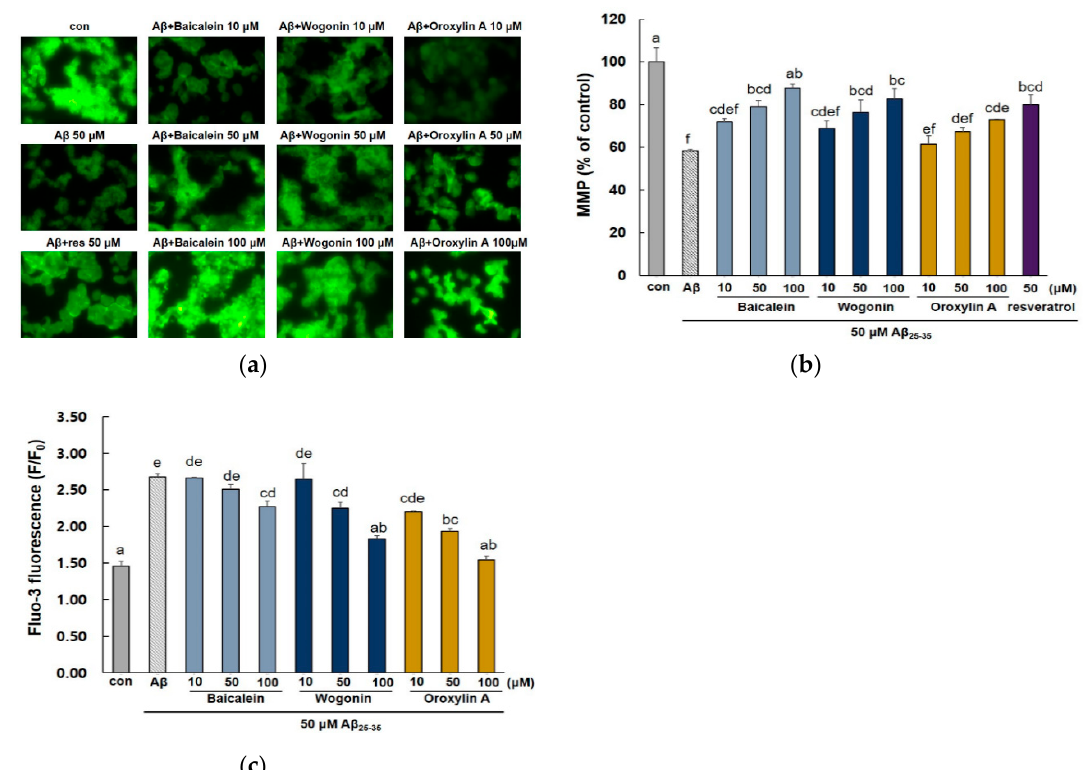
Figure 5. Effects of baicalein, wogonin, and oroxylin A on A β 25–35 induced mitochondrial dysfunction. The cells were pretreated with samples for 1 h and stimulated with A β 25–35 for 24 h. Mitochondrial membrane potential (MMP) was determined by Rhodamine 123 staining ( a ). Statistical analysis results of the percentage MMP through Rhodamine 123 intensity ( b ). Intracellular Ca 2+ levels were analyzed using Fluo-3AM ( c ). Different alphabets indicated significant difference at p < 0.05.